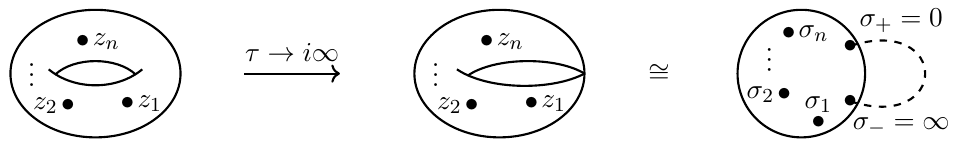
Figure 3 . The degeneration of the torus at (cid:28) ! i 1 pinches the A -cycle and yields the topology of a Riemann sphere. In particular, the pinched A -cycle introduces a pair of identi(cid:12)ed punctures (cid:27) + = 0 and (cid:27) (cid:0) = 1 on the Riemann